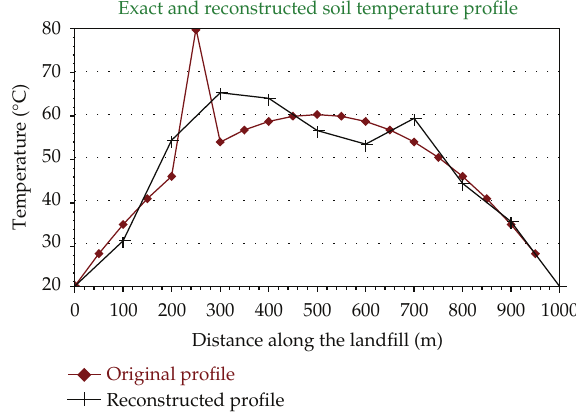
Figure 2: Ten intervals—Tikhonov’s regularisation factor.